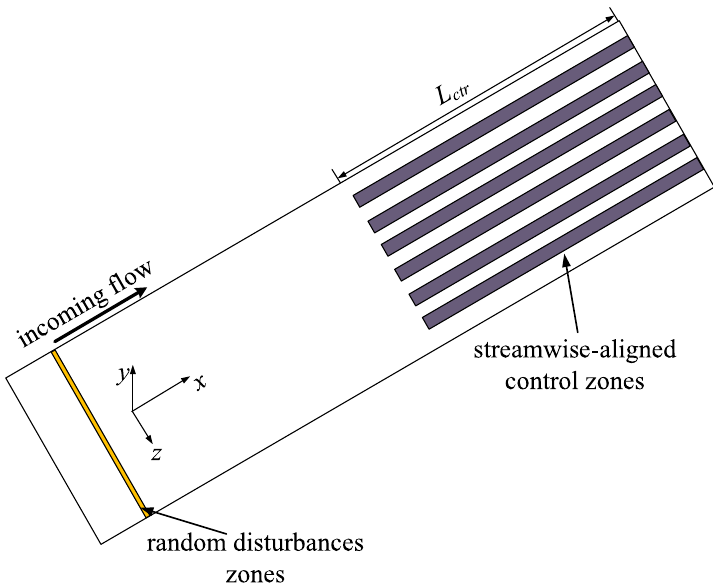
Fig. 1 Schematic of hypersonic flat-plate with streamwise-aligned control zones (each slot is equidistant from the